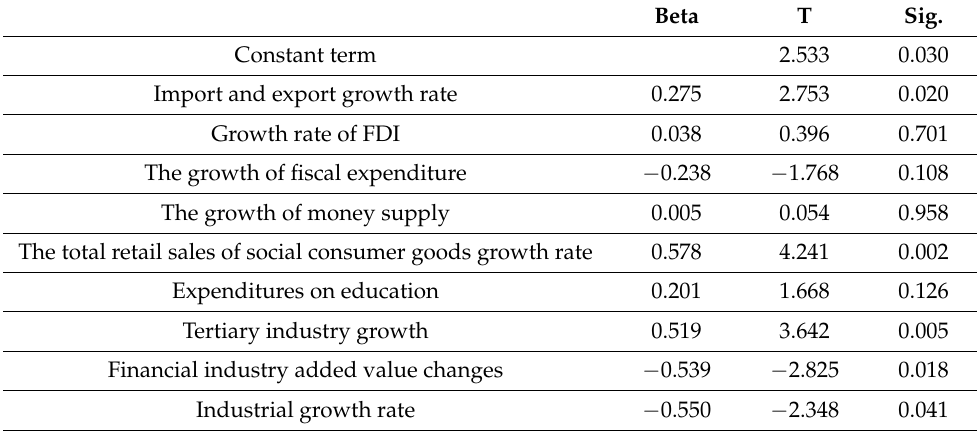
Table 3. Least squares regression